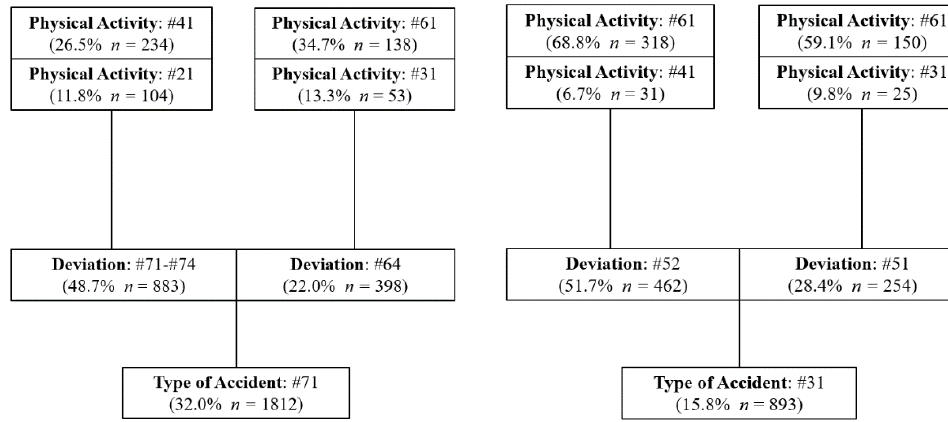
Figure 2. Characteristics of the Type of Accident in OP.